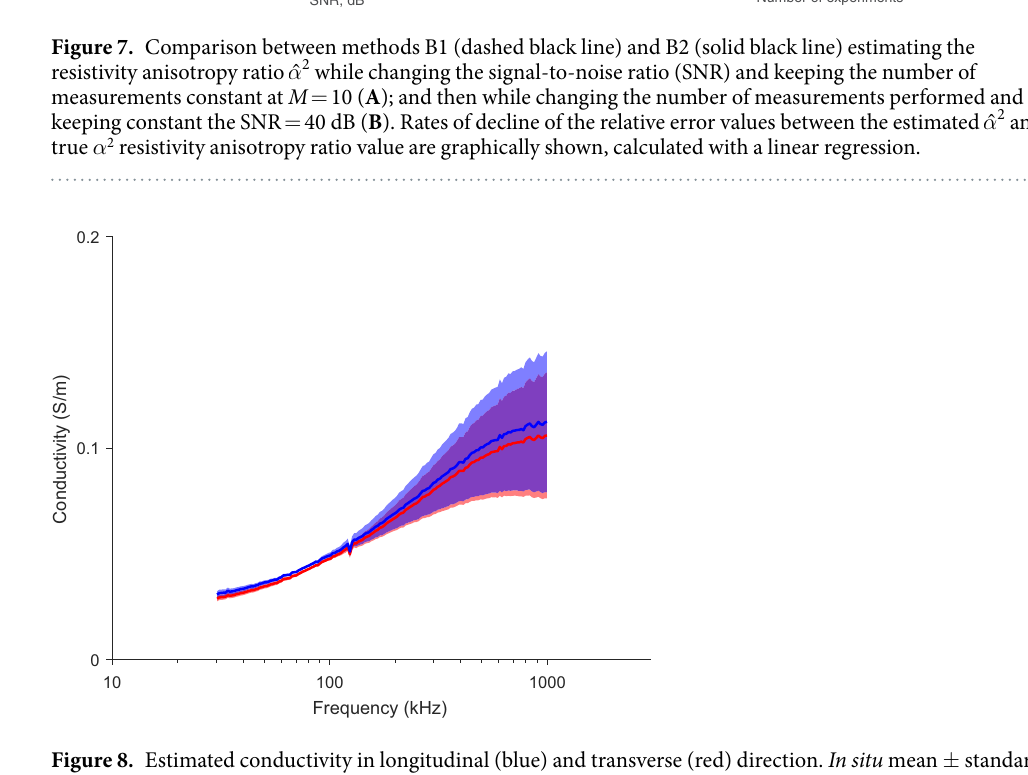
(number of measurements per angle M = 3) were then collected sequentially changing the electrodes’ configu- ration as detailed in Table 2. The aspect factors resulting from the separation between the needles g = 30 mm and the inter-electrodes’ distance h 1 = 1.5 mm, h 2 = 3.5 mm, and h 3 = 5 mm, were p 1 = 20, p 2 = 8.6, p 3 = 6. The reader is referred to Supplementary information, Part E for further information regarding the manufacturing of the needles. Data analysis. Multi-frequency muscle impedance data were analyzed using method S1 using MATLAB. We setup as in the in situ measurements. Calibration measurements were taken at room temperature immediately after immersing the needle electrode matrix into saline solution.